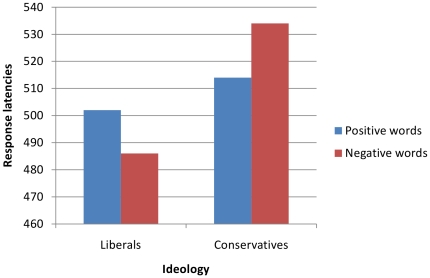
Response latencies to positive and negative words as a function of participants' ideology (Experiment 1).